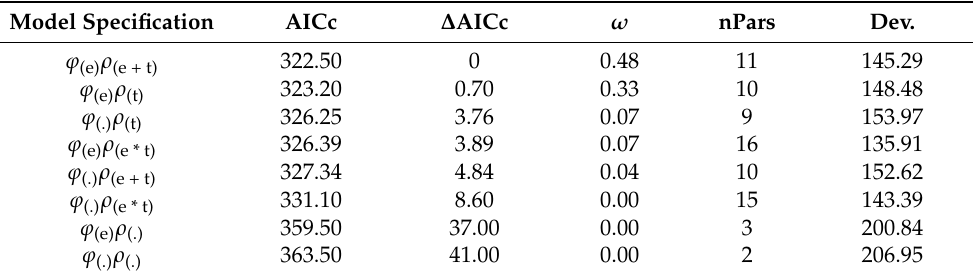
Table 3. Summary of hatchling survival models, including resighting probability ( ρ ) and survival probability ( ϕ ) and considering maternal characteristics for the 2017/2018 period. Female age and time interval were considered as fixed effect factors. Model selection was based on Akaike’s information criterion corrected for small sampling size (AICc); ∆ AICc is the difference between the current model and the one with the lowest AICc value. Model weights ( ω ), number of parameters (nPars) and relative deviance (Dev.) are also shown. See ESM Table S6 for statistical